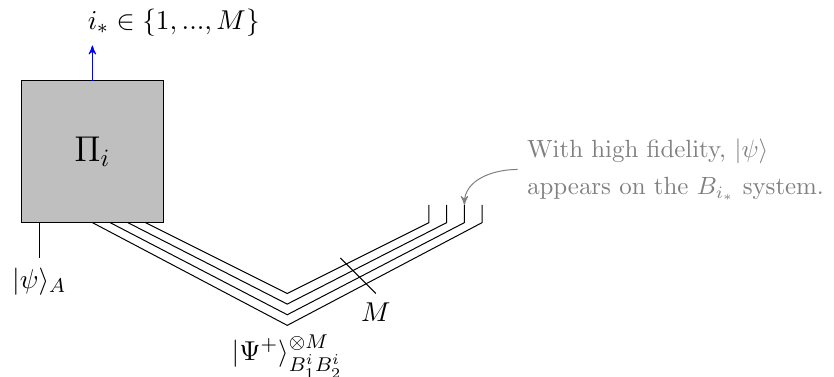
Figure 9. The port-teleportation protocol. A state j i is held in system A , along with M entangled systems j (cid:9) A i (cid:10) M where each j (cid:9) A i consists of n EPR pairs, where n is the number of qubits in A . B i 1 B i 2 The B i are referred to as \ports". A measurement with measurement operators f (cid:5) i g is performed 2 on the AB 1 B 2 : : : B M system producing output i (cid:3) 2 f 1 ; 2 : : : ; M g . The state j i then appears on 1 1 1 the B i (cid:3) system with a (cid:12)delity controlled by 1 =M 2